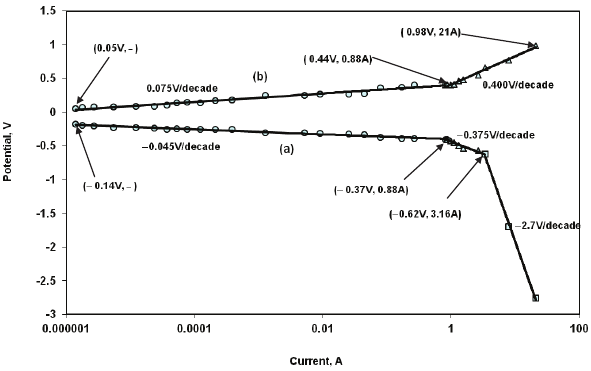
Figure 1. Concurrent steady state polarization plots in molten CaCl bath at 950°C: (a) cathodic for TiO 2 (b) anodic for